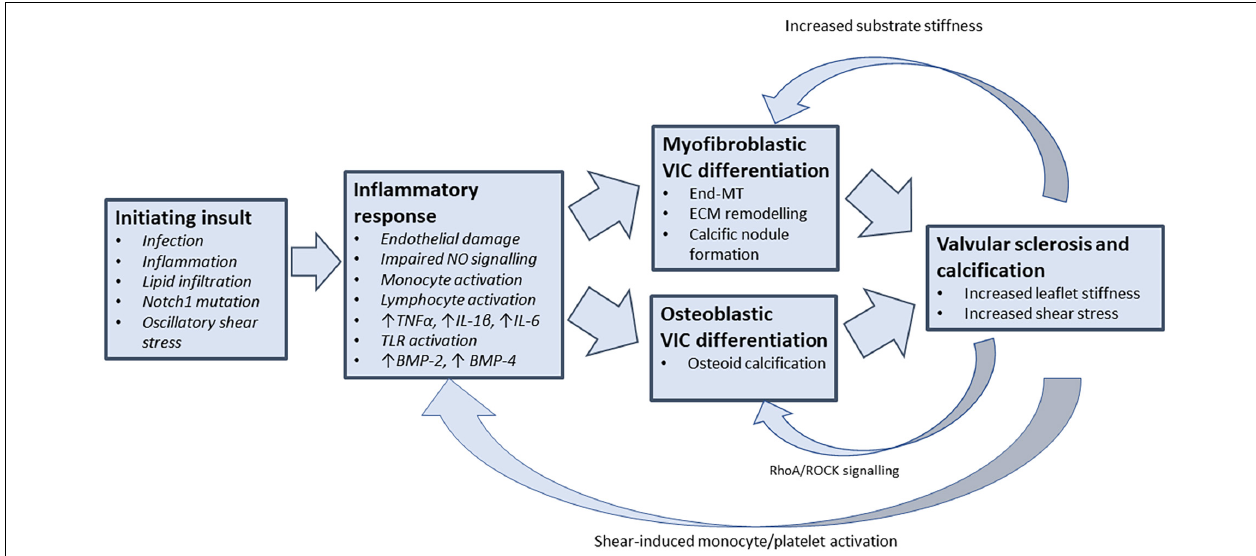
FIGURE 1 | Feedback mechanisms that perpetuate valvular inflammation in CAVD. Understanding the drivers of chronic valvular inflammation are key to arresting the progression of CAVD. Following the initiation of valvular inflammation and stenosis, mechanosensitive feedback pathways may provide the coupling link that promotes further VIC differentiation and valvular inflammation (TNF- α , tumour necrosis factor alpha; IL-1 β , interleukin 1-beta; IL-6, interleukin 6; BMP, bone morphogenetic protein; VIC, valvular interstitial cell; End-MT, endothelial-mesenchymal transition; ECM, extracellular matrix; ROCK, rho-associated protein kinase).